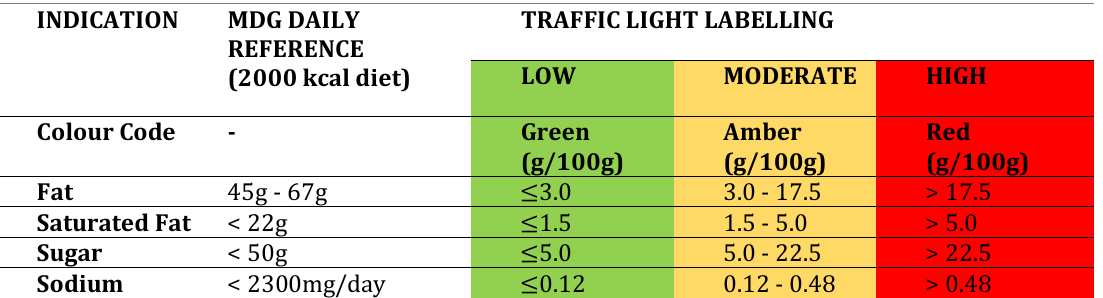
Table 2: Cut-Offs used for traffic light labels for a usual food serving or food based on Malaysian Dietary Guidelines 2010.